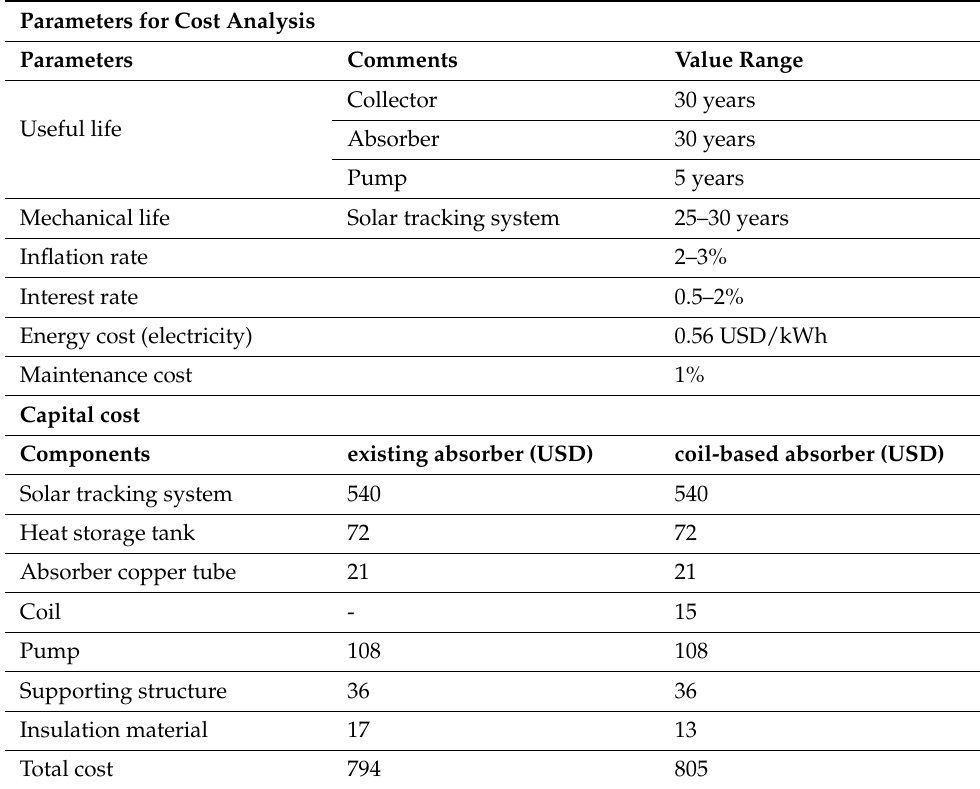
Table 2. Parameters for cost analysis and capital cost of existing absorber and coil-based absorber using nanofluid as heating